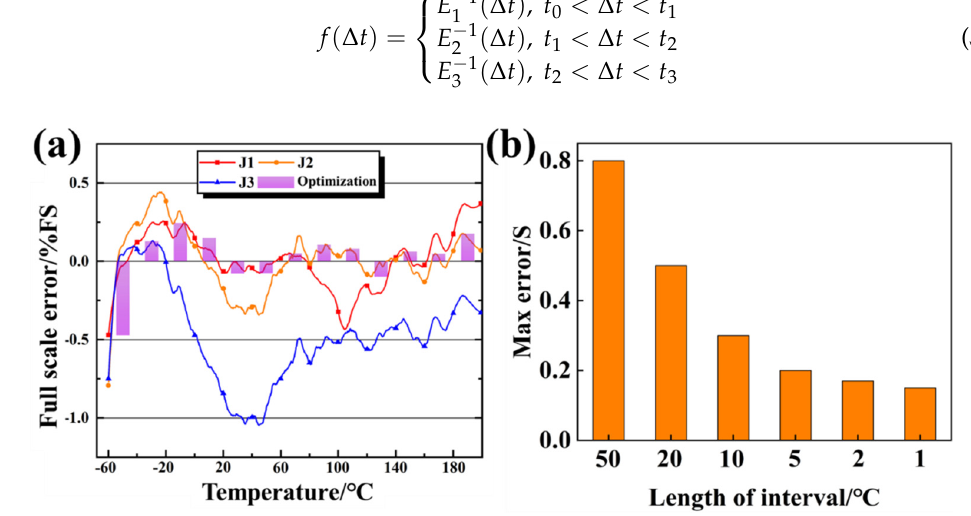
Figure 9. Data optimization results. ( a ) Full-scale error curve of the calibrated sensor. ( b ) Maximum full-scale error under different interval lengths.